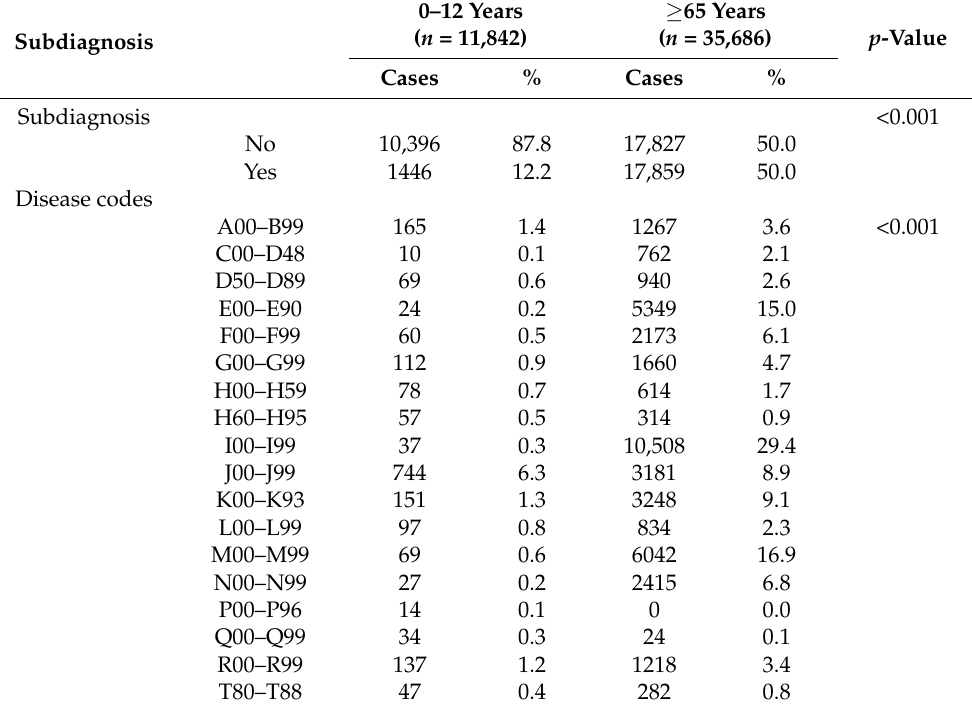
Table 4. Subdiagnosis codes in children and elderly patients with